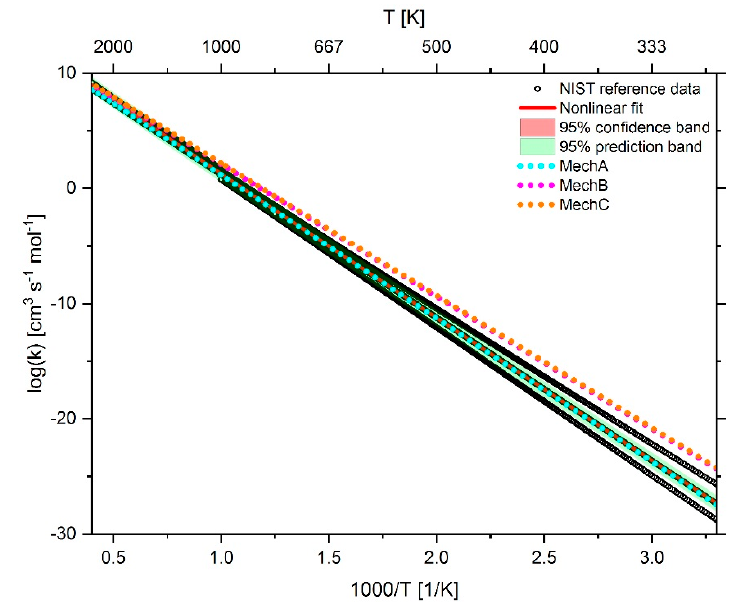
Figure 5. Comparison of the reaction rate coefficient of reaction 44 (CH 4 + O 2 ↔ CH 3 + HO 2 ) of MechA to MechC as well as the fitted rate coefficient using reference data from the NIST database.